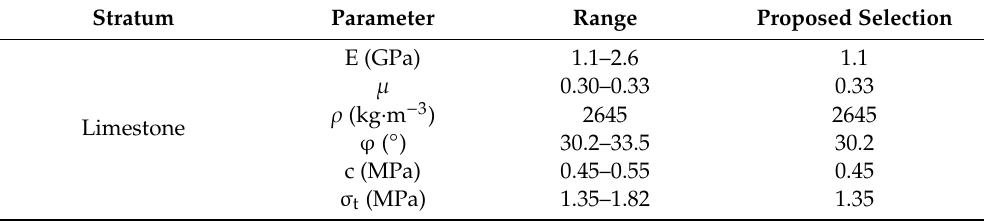
Table 4. Parameter selections of the rock mass in the finite element model.